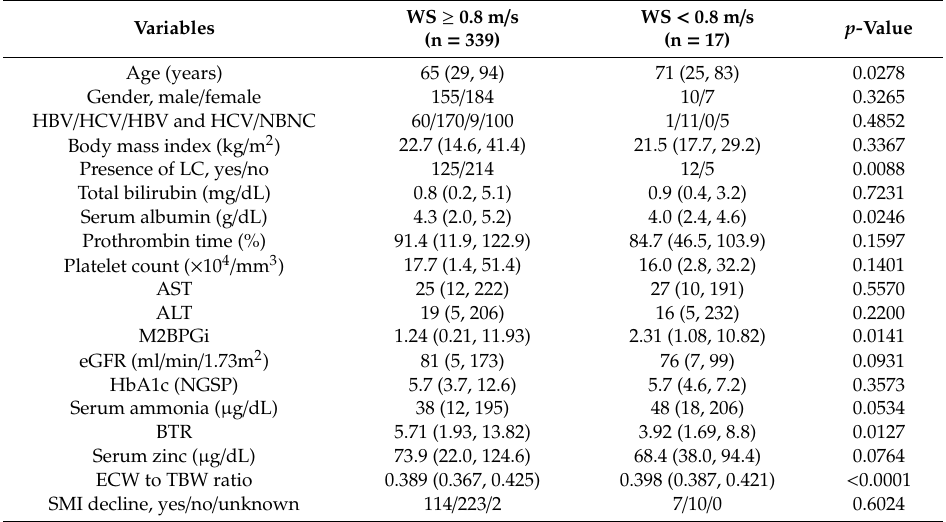
Table 3. Univariate analyses of factors linked to walking speed (WS) decline ( < 0.8 m /